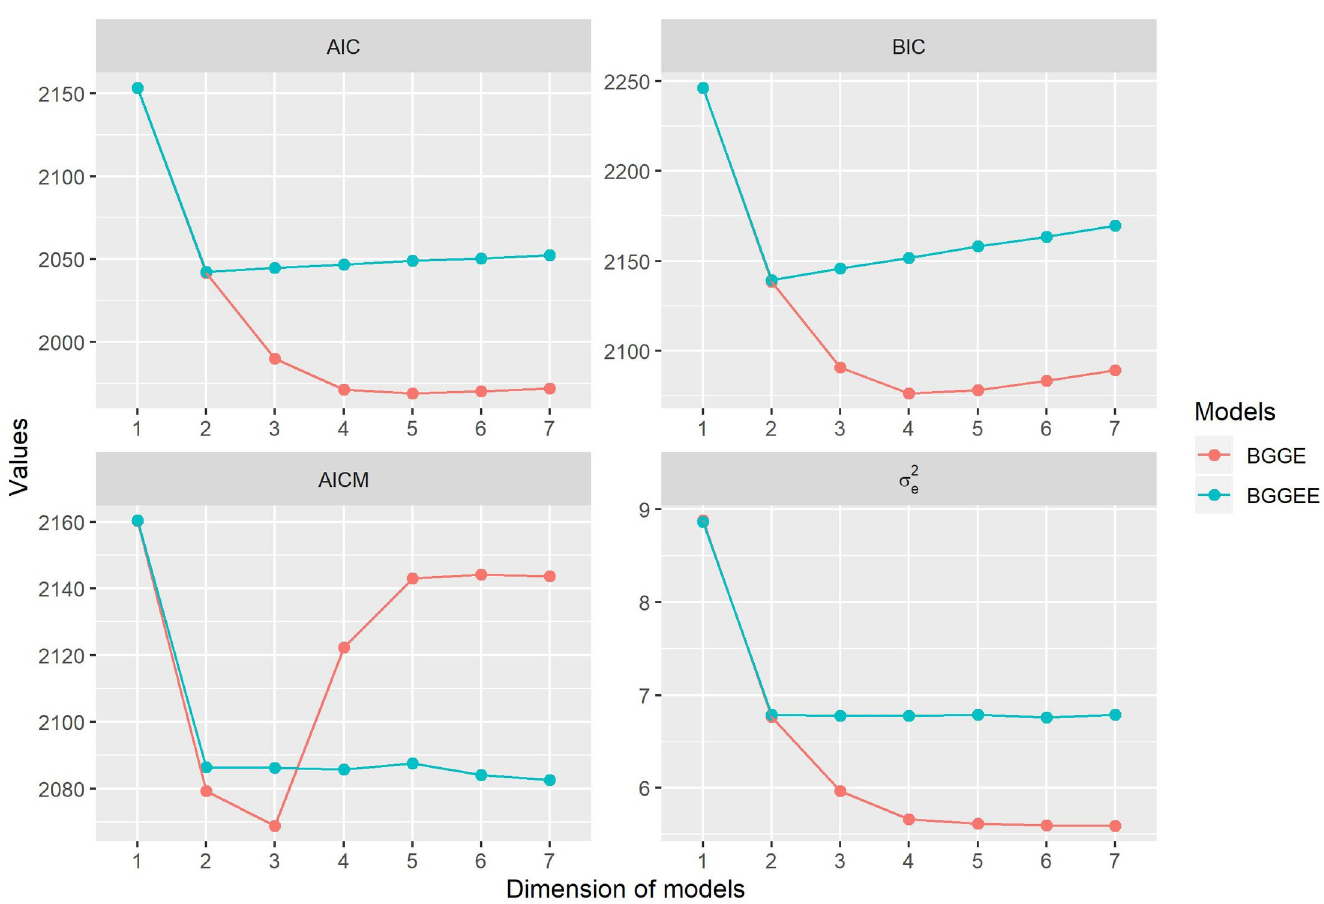
Fig 2. Results of the AIC, BIC and AICM and residual variance σ 2 models for k = 1, ... , 7.